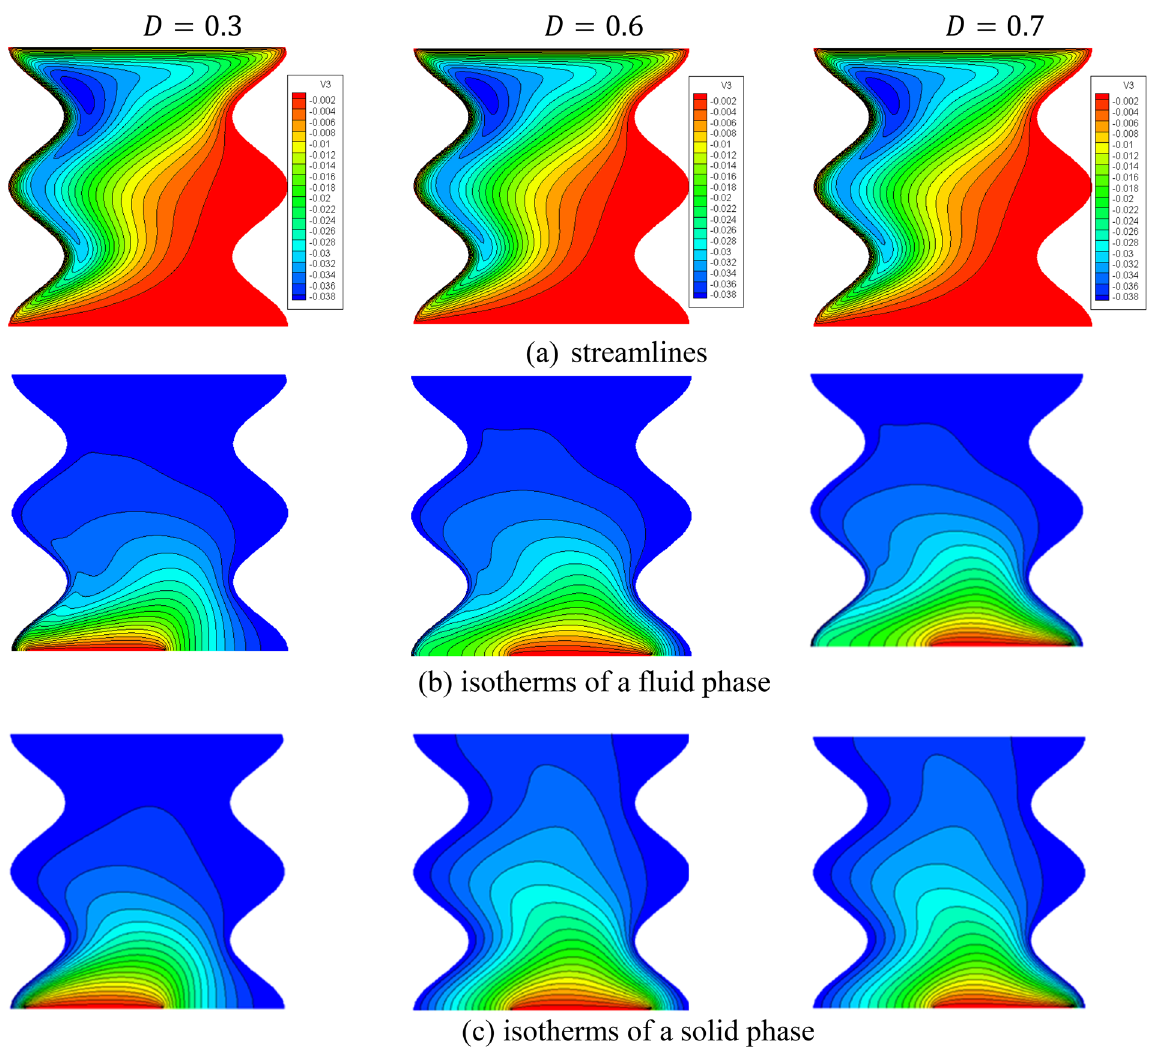
Figure 22. Contours of ( a ) streamlines, ( b ) isotherms of a fluid phase, and ( c ) isotherms of a solid phase below the changes on a heat source position D for a hybrid nanofluid at φ Cu = φ TiO 2 = φ/ 2, φ = 0.05, B = 0.5, Q = 1, R d = 0.5, k r = 1, ε = 0.5, k fs = 1, Da = 10 − 3 , H ∗ = 10, Ha = 10.